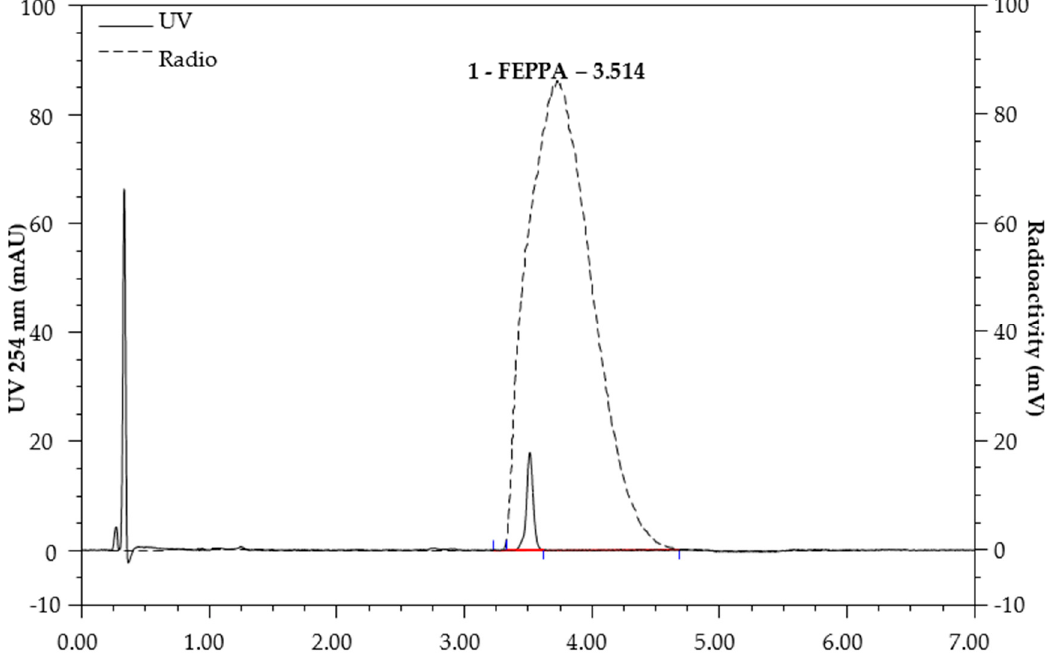
Figure 3. Analytical HPLC chromatogram (radio and UV).